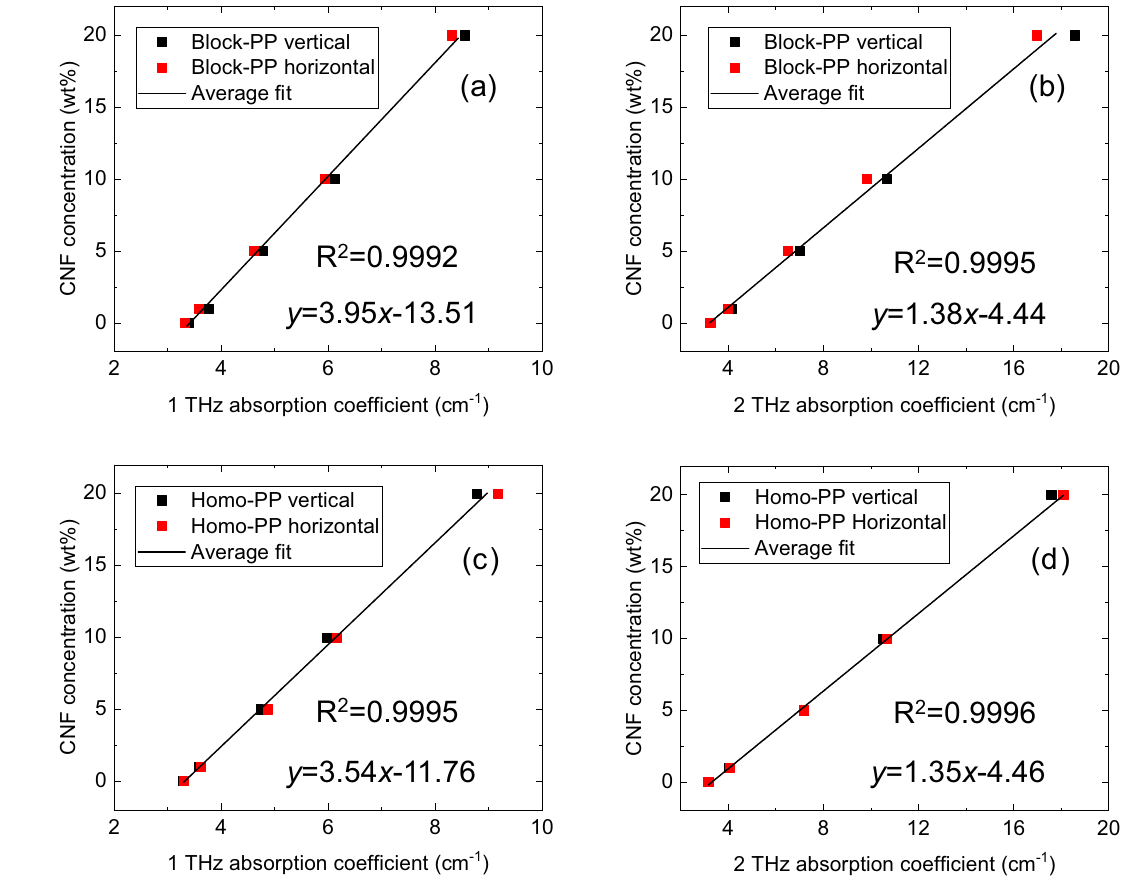
Figure 7. Relationship between THz absorption and CNF concentration, and linear fit obtained using the least- squares method: ( a ) Block-PP (1 THz), ( b ) Block-PP (2 THz), ( c ) Homo-PP (1 THz), ( d ) Homo-PP (2 THz). Solid line: linear fit obtained by using least-squares